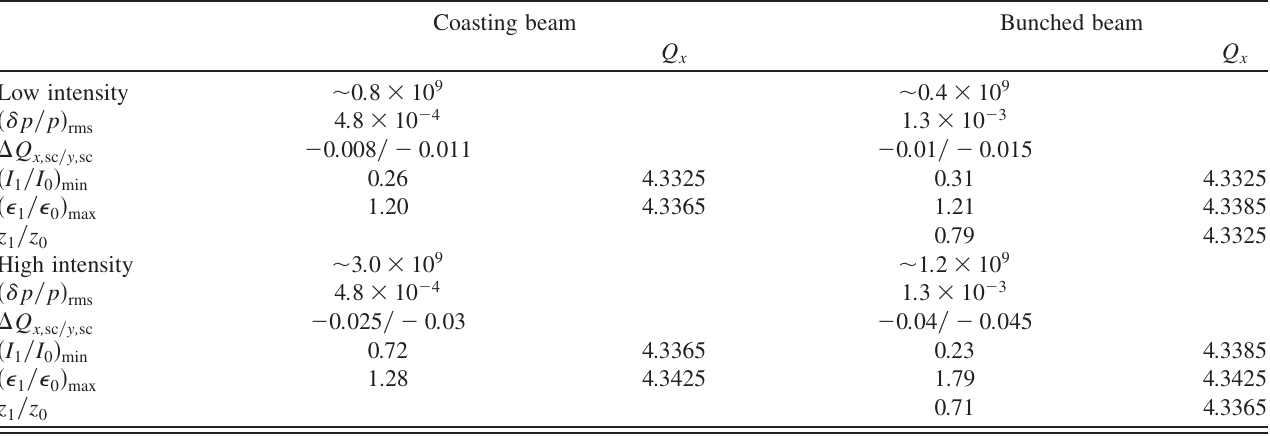
TABLE II. In this table are summarized the values of the essential quantities measured in each of the four measurement sets: Space charge strength, maximum beam loss, maximum emittance increase, and bunch length at the end of the storage. These quantities are grouped in rows according to the intensity of the beam (low/high intensity) and in columns according to whether the beam is bunched or coast. The column Q x provides the horizontal tune at which those quantities are measured. In all measurements the vertical tune has ¼ 3 : 245 . From this table it is shown that only when high intensity and synchrotron motion are been kept constant at Q y 0 simultaneously present large emittance growth occurs as a result of the space charge induced periodic crossing of the third order resonance. The uncertainties in these parameters are the same as those in Figs. 6, 8, 13, and 14. Coasting beam Bunched beam Q x Low